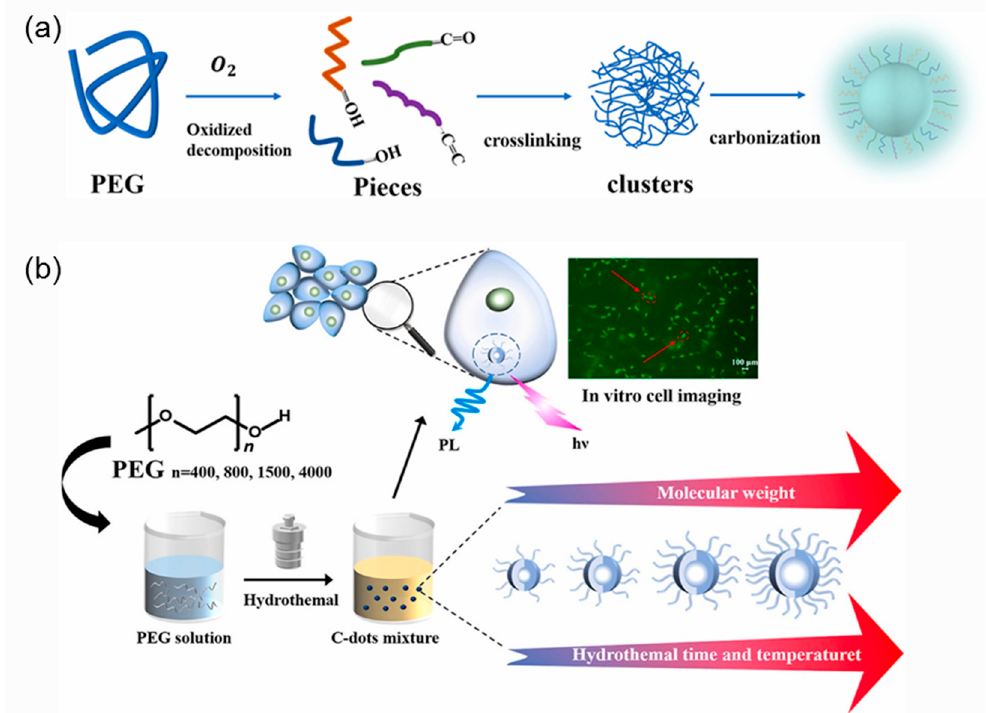
Figure 3. ( a ) Schemes for the preparation of CDs from PEG precursors with different MW. ( b ) The molecular weight of PEG precursors had a large influence on the fluorescence, size, surface chemis- try, bioimaging performance, and thermal stability of CDs (reprinted with permission from [98], 2022, Elsevier).